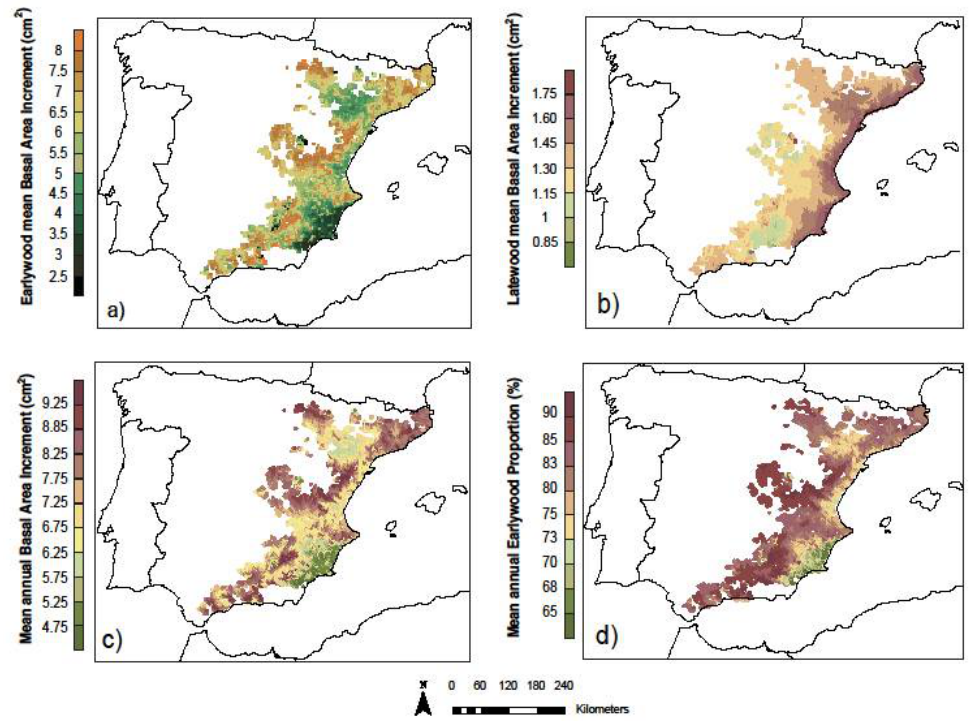
Figure 6. Distribution prediction models. ( a ) Mean annual EW growth. ( b ) Mean annual LW growth. ( c ) Mean annual ring width growth. ( d ) Proportion of